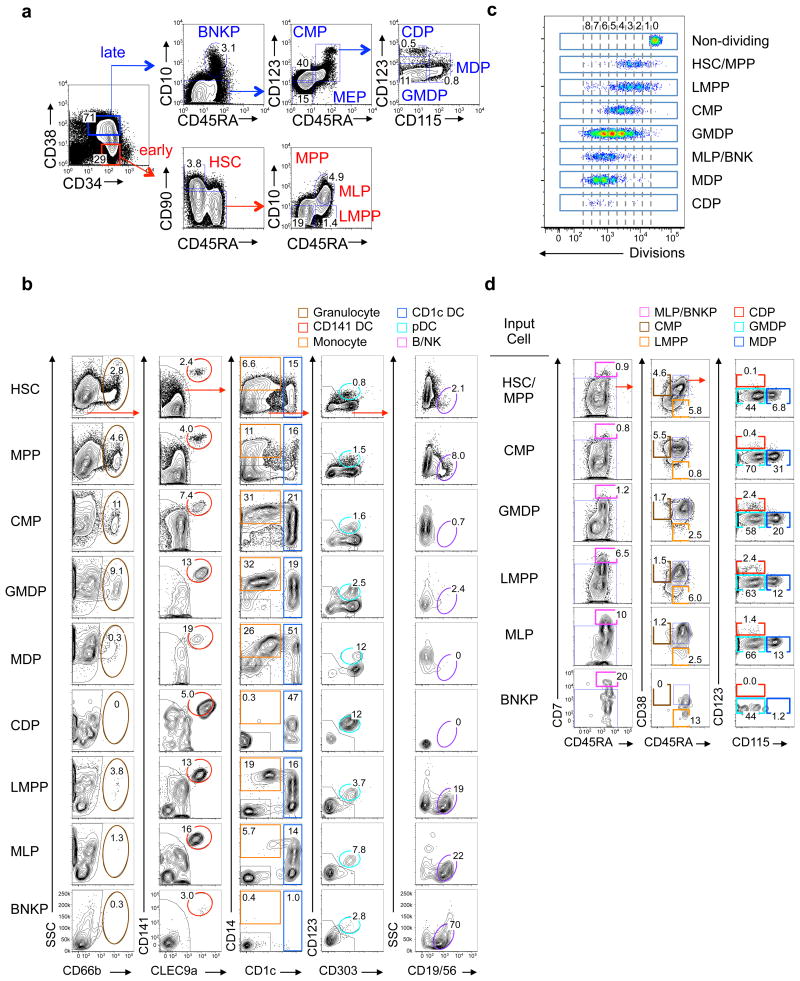
Marker-defined hematopoietic progenitors exhibit hierarchical and convergent potency(a) Flow cytometry plot showing gating scheme of progenitor populations from a representative sample of seventeen human cord blood units. Starting gate: Lin(CD3/19/56/14/16/66b/1c/303/141)-. BNKP, B/NK progenitor; CMP, common myeloid progenitor; MEP, megaerythrokaryocyte progenitor; GMDP, granulocyte-monocyte-DC progenitor; MDP, monocyte-DC progenitor; CDP, common DC progenitor; HSC, hematopoietic stem cell; MPP, multipotent progenitor; LMPP, lymphoid-primed multi-potent progenitor; MLP, multi-lymphoid progenitor. (b) Flow cytometry plots showing output of granulocytes (brown), monocytes (orange), CD1c+ DCs (blue), CD141+ DCs (red), pDCs (cyan) and B and NK cells (purple) from 100 cells from each indicated population after culturing in MP+FSG condition for 14 days. Shown are live, singlet CD45+ cells and numbers indicate mean % of total CD45+ cells produced from five independent experiments. (c) Concatenated FACS plots showing number of cell divisions (CFSE signal dilution) of indicated populations descended from 1,000 HSCs that were sorted as in a, labeled with CFSE and cultured for 7 days. Populations were gated as shown in d. Plot is representative of four independent experiments. (d) Representative flow cytometry plots showing intermediate output from HSC/MPPs, CMPs, LMPPs, MLPs and BNKPs after culturing 1,000 cells of each population for 7 days. Shown are live, singlet CD45+Lin(CD3/19/56/14/16/1c/303/141)-CD34+ cells. Numbers indicate mean % from total CD34+ cells from four independent experiments.